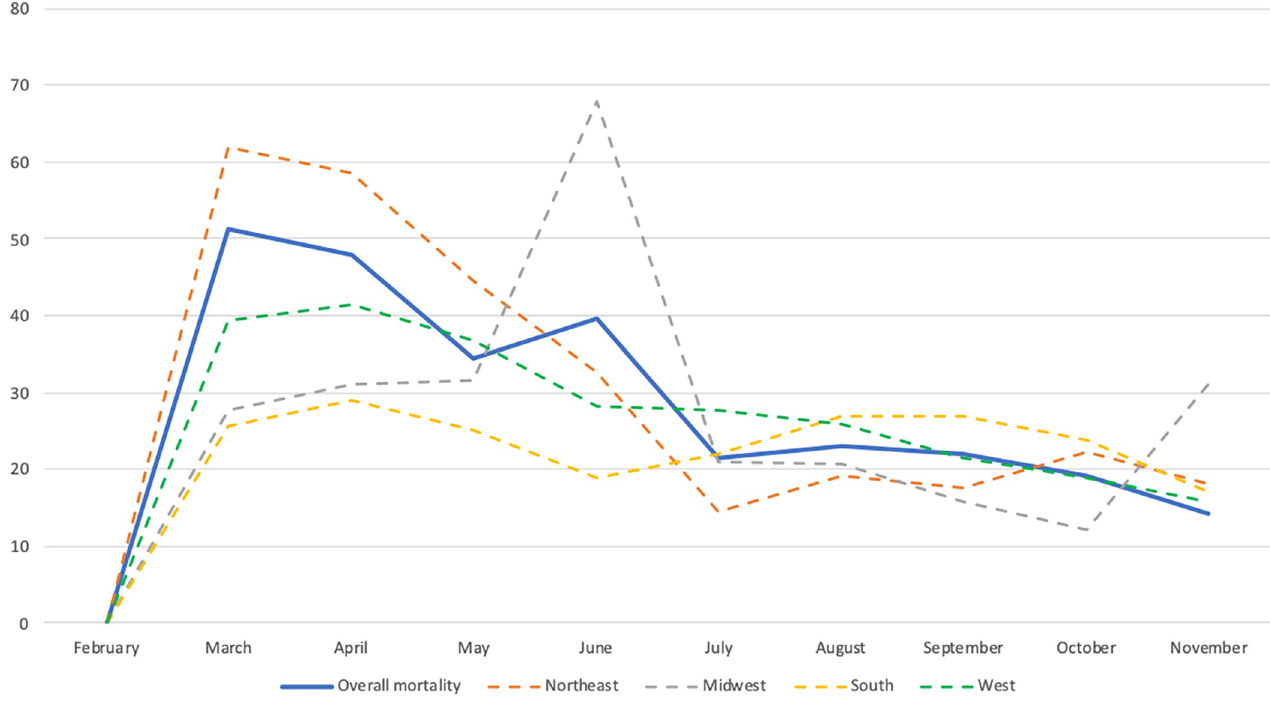
Fig 4. Monthly mortality rates among hospitalized COVID-19 patients by census